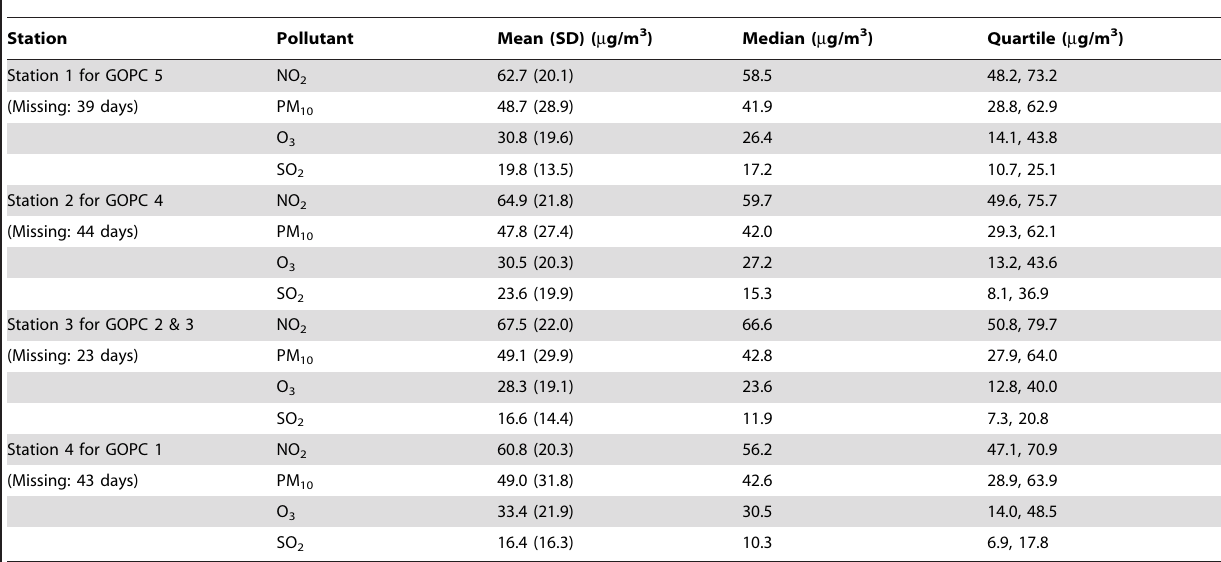
Table 2. Summary statistics of the four air pollutants in the four monitoring stations from 1 January 2008 to 31 December 2010.